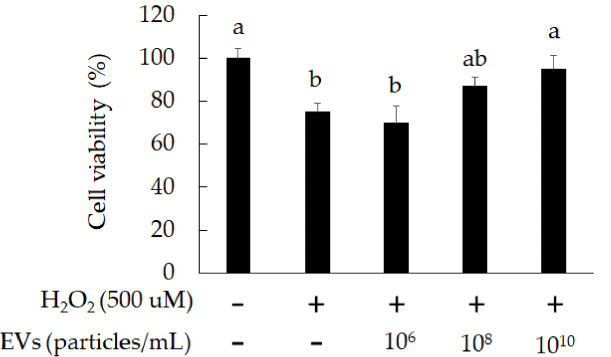
Figure 4. The attenuation of cell death by L. crispatus -derived EVs in 3A-sub-E placental cells treated with H 2 O 2 for 24 h. Data are expressed as mean ± SD (n = 3). Significant differences ( p < 0.05) are indicated by different letters (a, ab, b) .